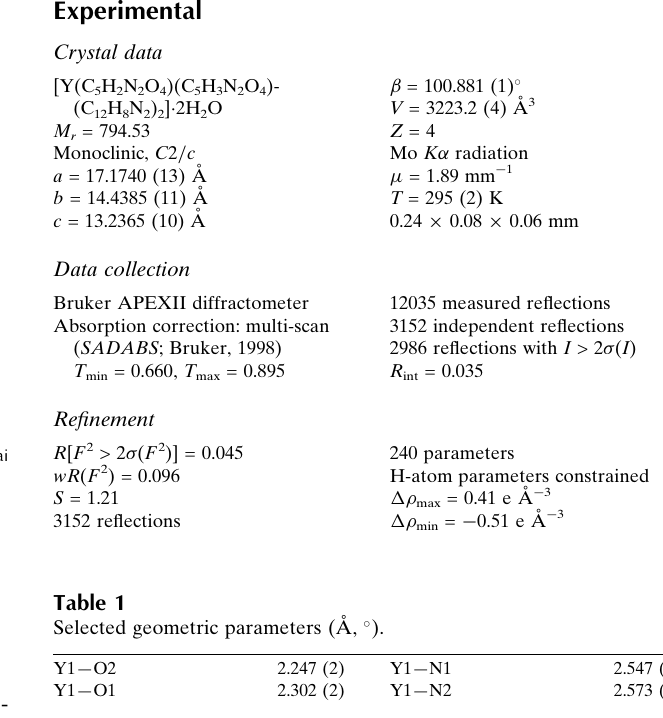
Bruker APEXII diffractometer Absorption correction: multi-scan